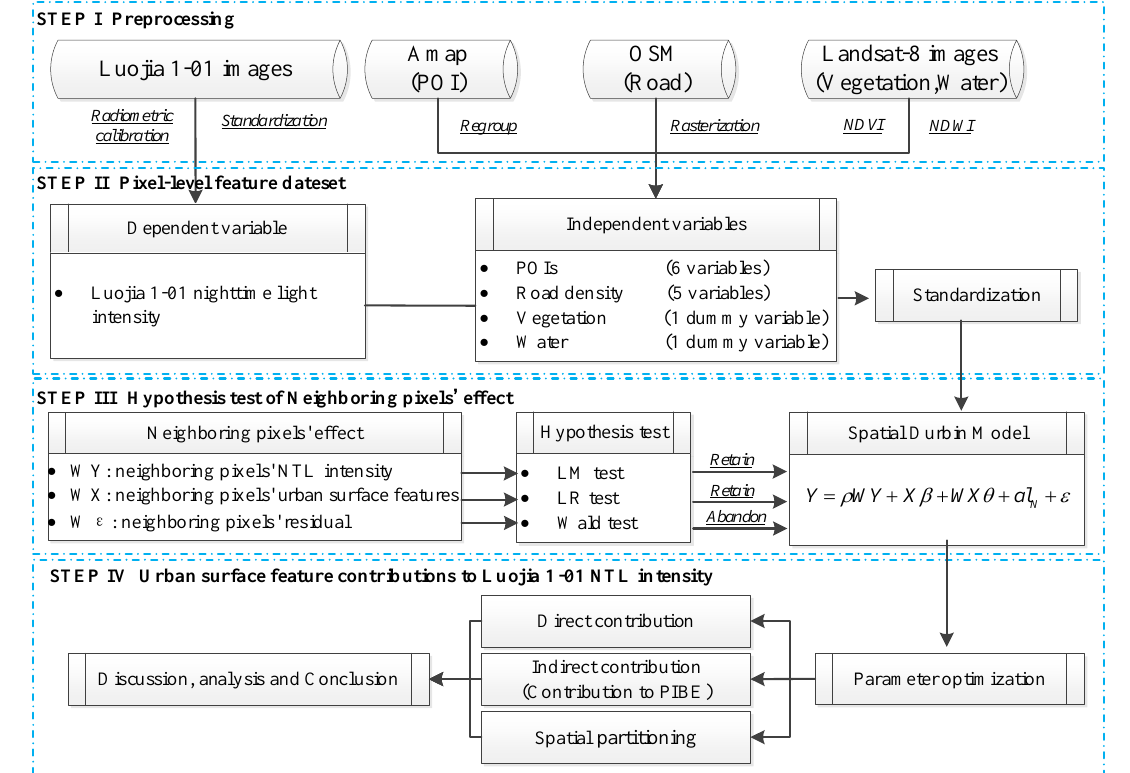
Figure 3. Flowchart. Figure 3.